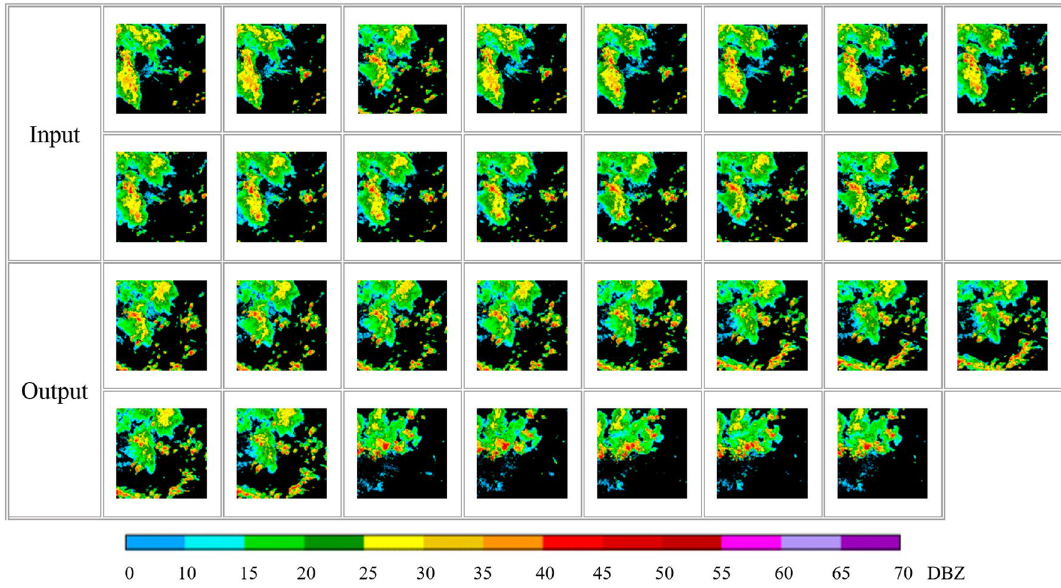
Figure 7. Image after visualization of a set of samples in the